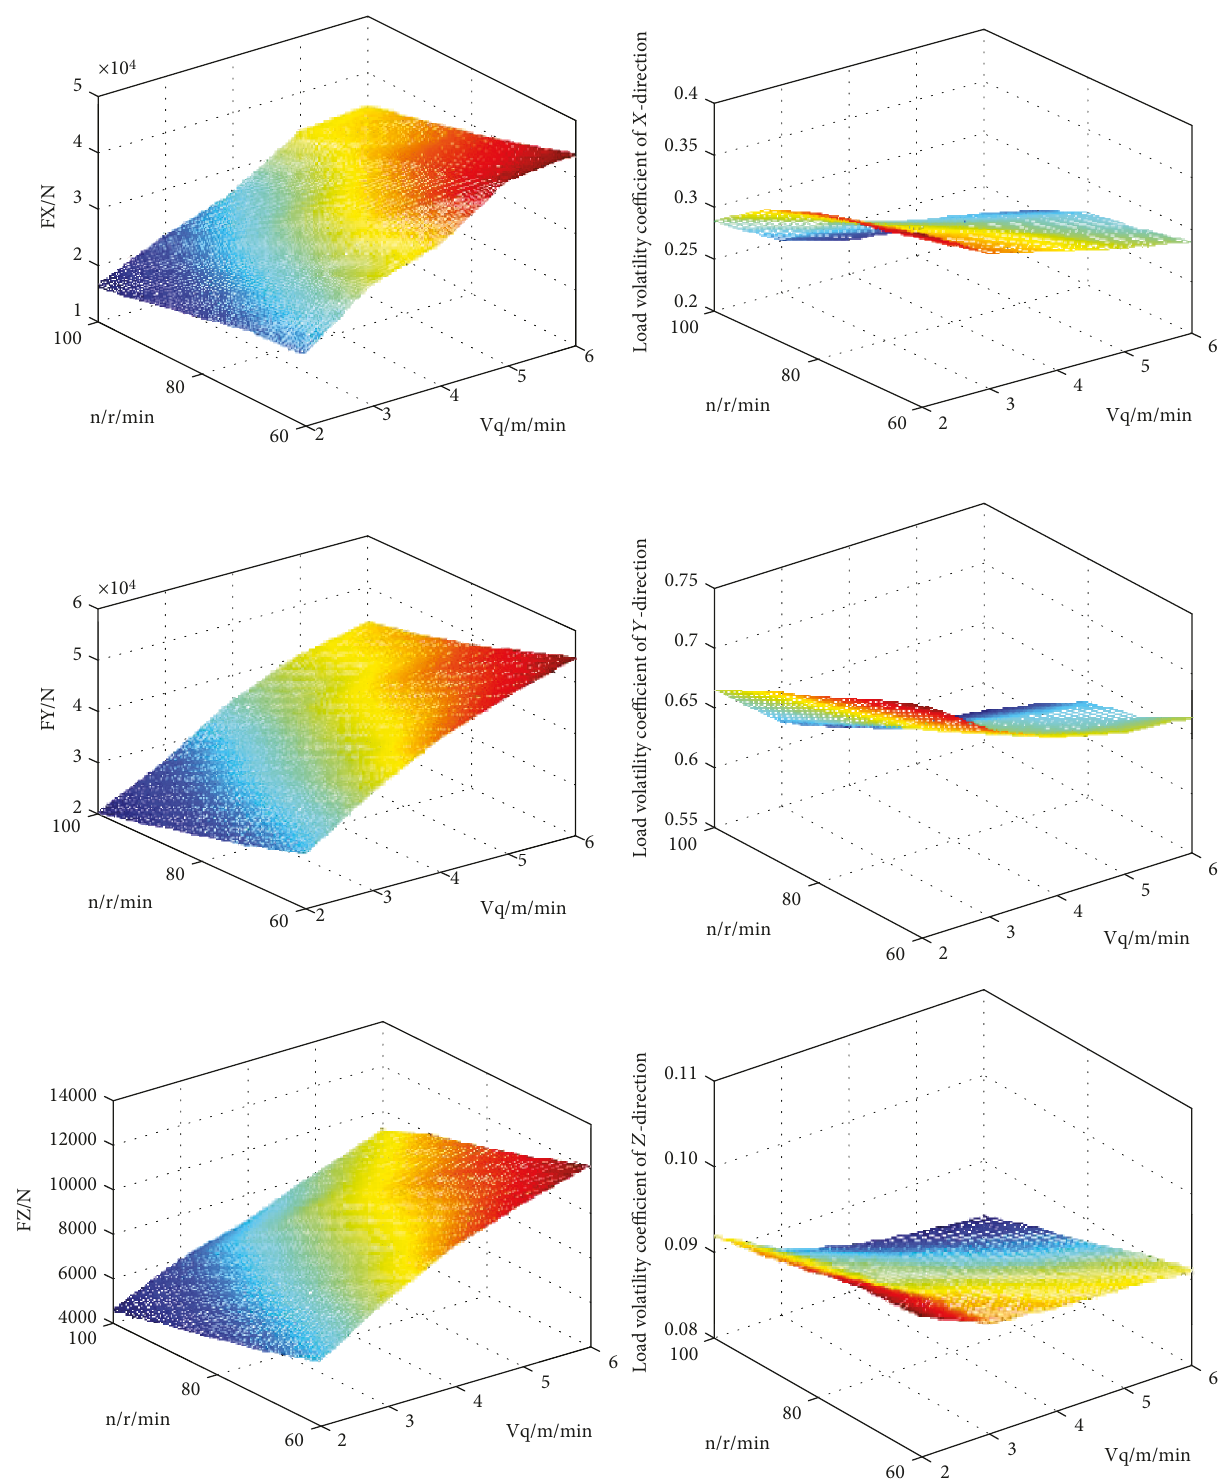
Figure 9: Relation between the motion parameters and the triaxial force of the